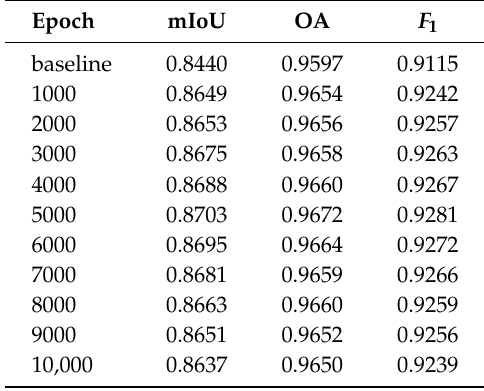
Table 2. Performance of adding Bi-SAD on the baseline model at different training epoch. The epoch of 5000 is the optimal, the others almost convergence to a same point.